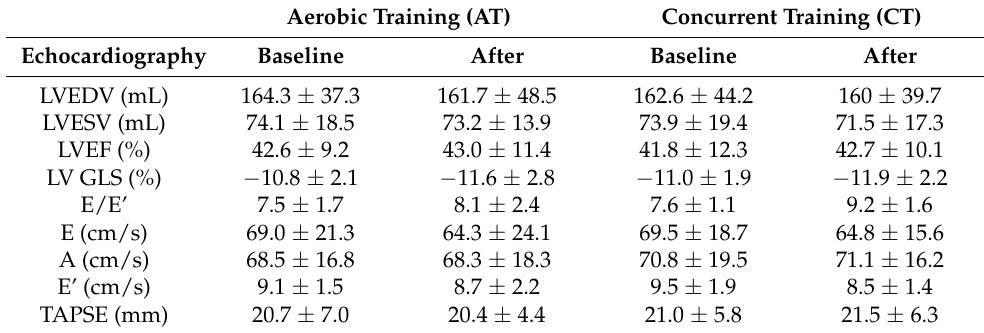
Table 3. Changes in echocardiographic parameters at baseline and after training.